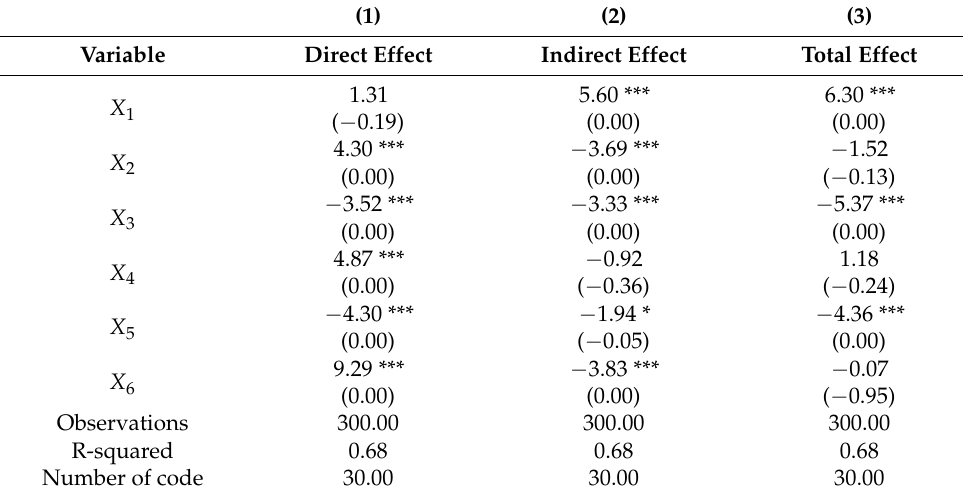
Table 12. Three effect estimation